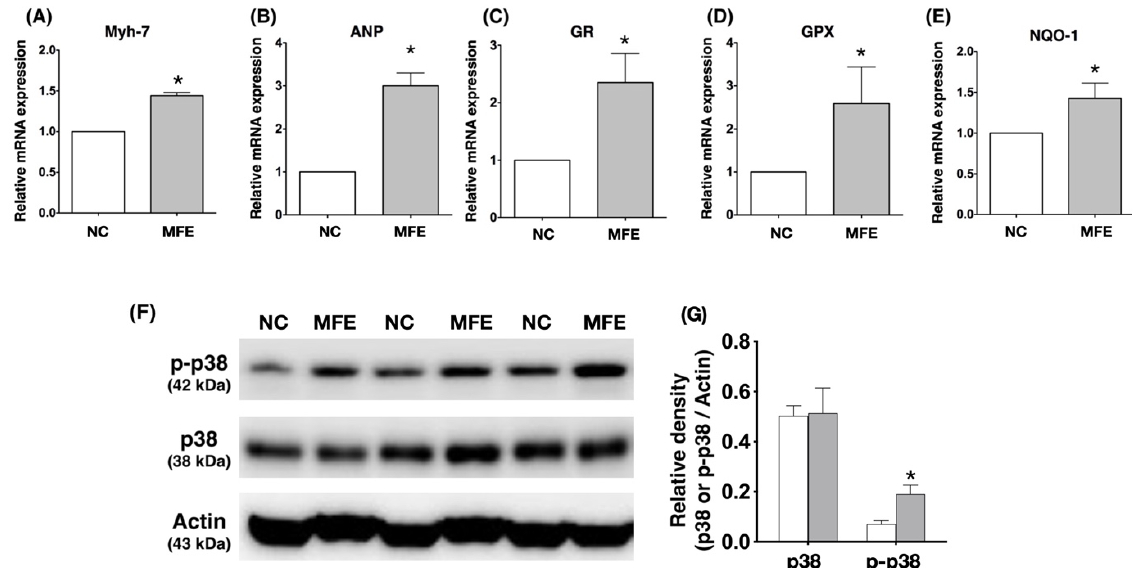
Figure 6. Activation of stress response signaling in the myocardium of offspring with maternal fructose exposure. ( A ) mRNA expression level of Myh-7. ( B ) mRNA expression level of ANP. ( C ) mRNA expression level of GR. ( D ) mRNA expression level of GPX in the myocardium. ( E ) mRNA expression level of NQO-1 in the myocardium. ( F ) Protein expression level of phosphorylated and total p38-MAPK in the myocardium. ( G ) Comparisons of the ratio of phosphorylated to total p38-MAPK expression in the myocardium of offspring. NC, normal control. MFE, maternal fructose exposure. TAC, transverse aortic constriction. Scale bar in right lower corner of ( C ) indicates 50 µm. NC, normal control. MFE, maternal fructose exposure. Myh-7, myosin heavy chain-7. ANP, atrial natriuretic peptide. GR, Glutathione reductase. GPX, Glutathione peroxidase. NQO-1, NAD(P)H dehydrogenase quinone 1. * indicates significance compared with NC group.